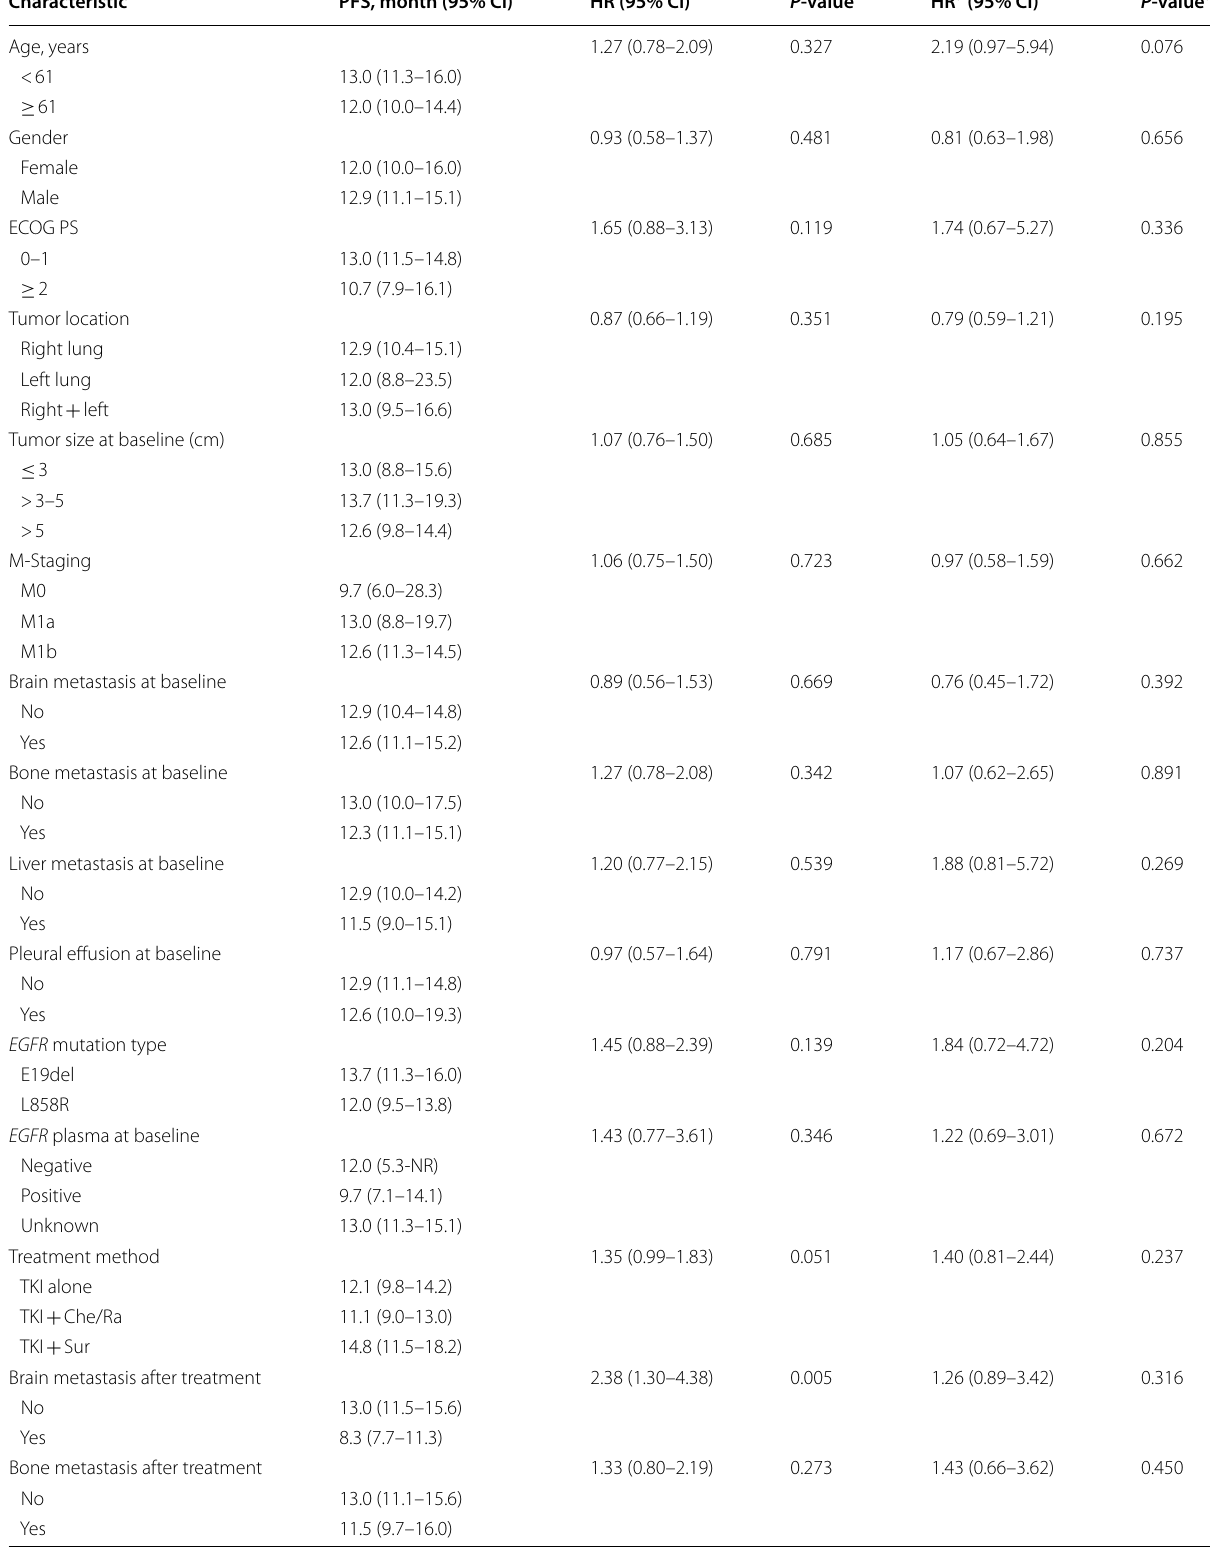
Table 2 Univariate analysis for progression-free survival